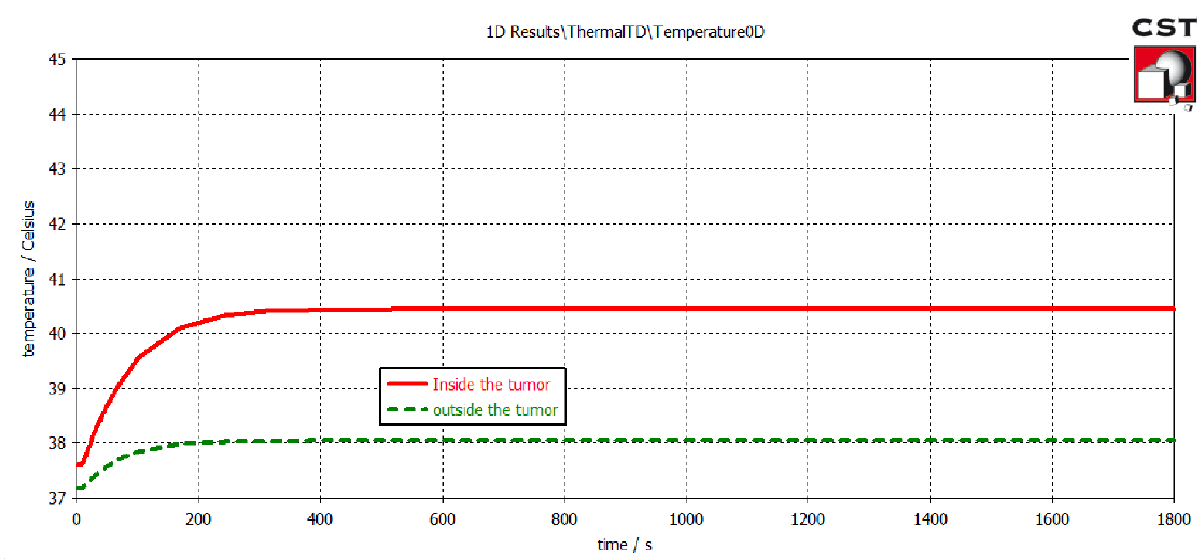
unsatisfactory and did not achieve the required tempera- ture.